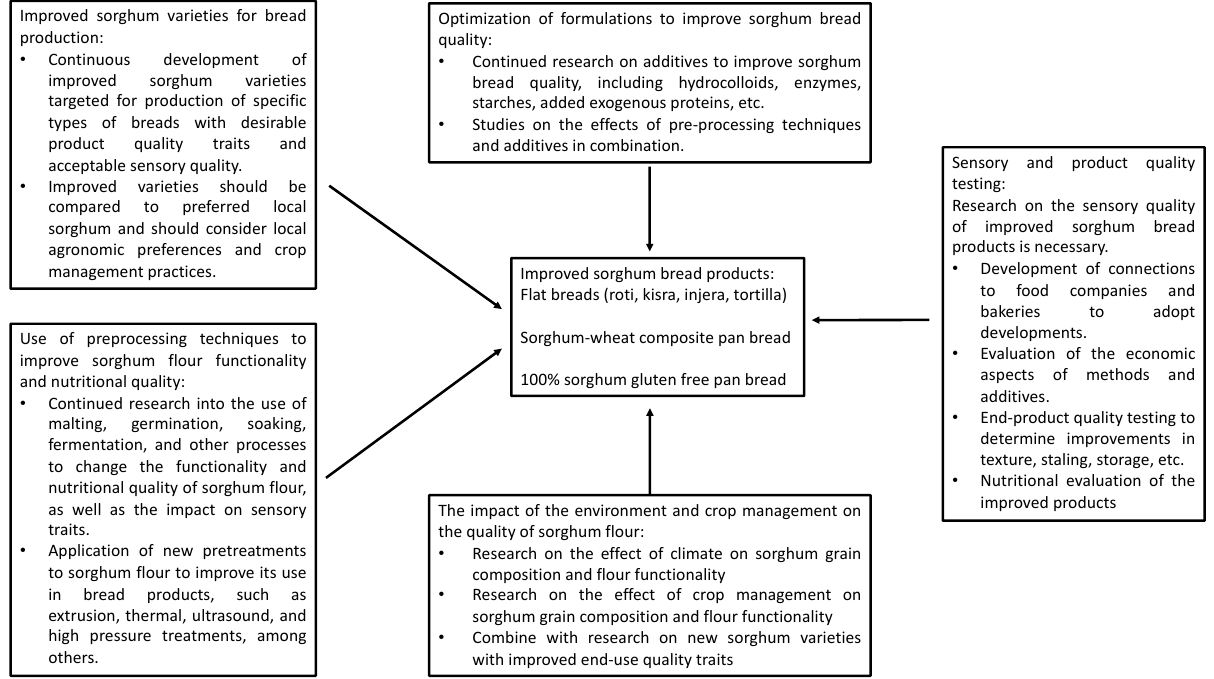
Figure 2. The future perspectives to improve high-quality sorghum breads.